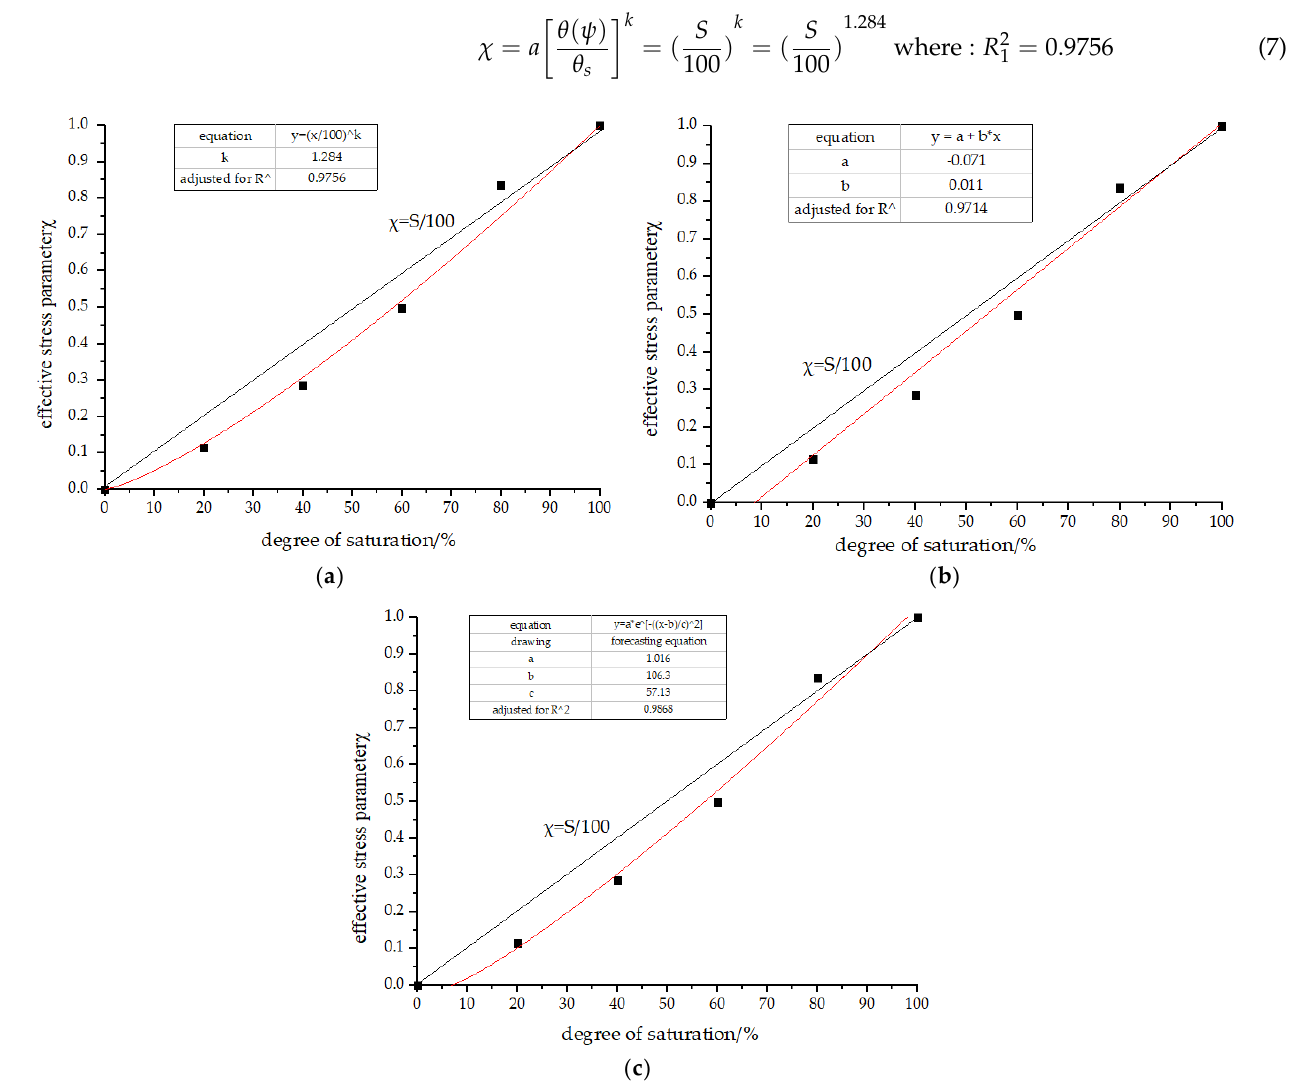
Figure 9. Simulation diagram of the relationship curve between saturation and the effective stress parameter. ( a ) Khalili N’s conjectures curve fitting diagram [33]; ( b ) Van apalli and Fred lund’s conjectures curve fitting diagram [34]; and ( c ) the forecasting equation curve fitting diagram. Meanwhile, the conjecture of Vanapalli and Fredlund’s equation for unsaturated soil strength at different moisture contents [34] can also be established based on the experi- mental data, as shown in Figure 9b: